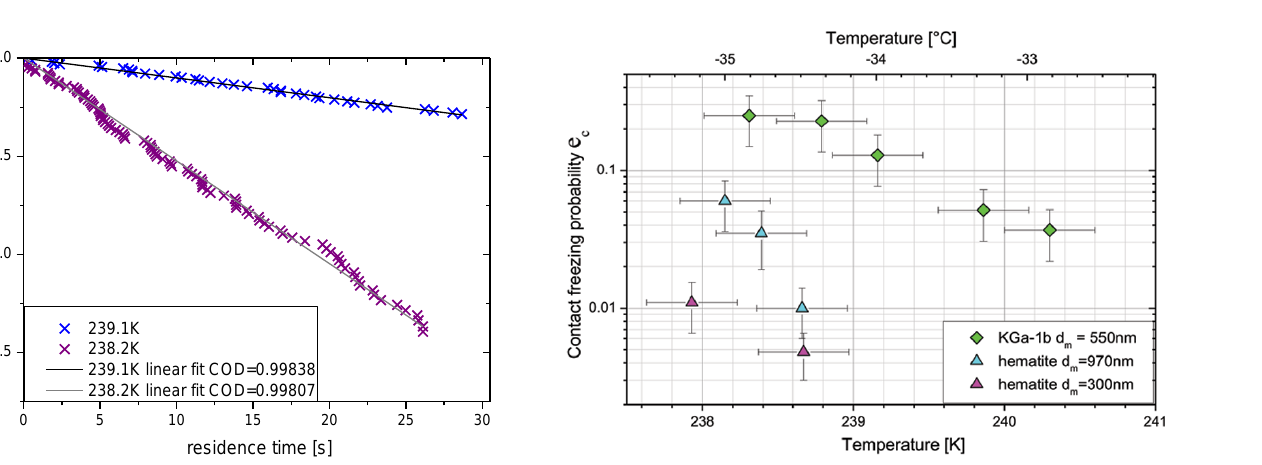
Fig. 7. Example measurements of contact freezing curves.